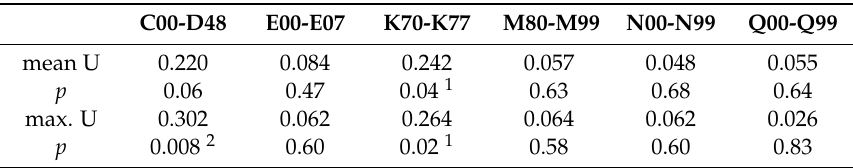
Table 3. Pearson correlation coefficients for mean and maximum U concentrations per county with incidence rates ( n = 76).